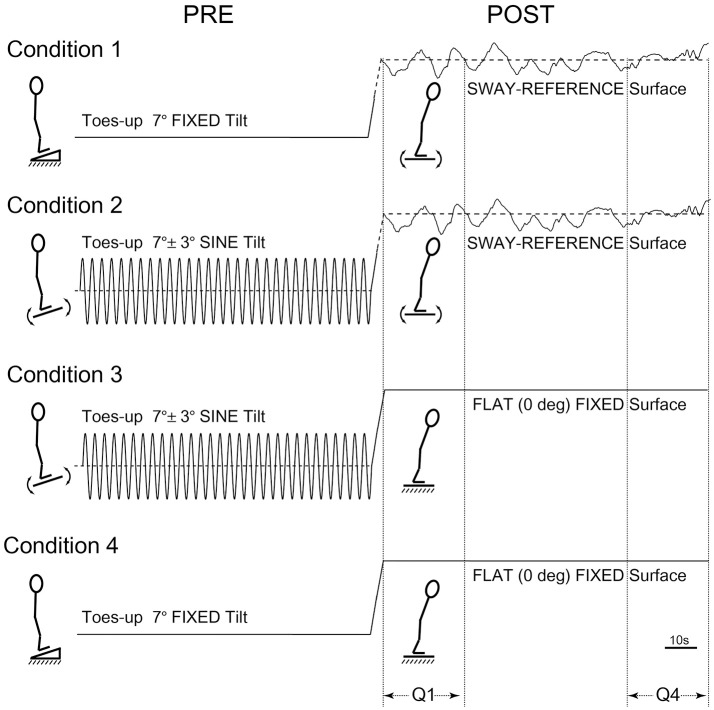
Postural test conditions. Condition 1: toes-up static-ramp for 120 s followed by standing on a sway-referenced surface for 120 s. Condition 2: toes-up sine-ramp (7° ± 3° * sinπt2 at 0.25 Hz) for 120 s followed by standing on a sway-referenced surface for 120 s. Condition 3: toes-up sine-ramp (7° ± 3° * sinπt2 at 0.25 Hz) for 120 s followed by quiet-stance on a static flat surface for 120 s. Condition 4: toes-up static-ramp (7°) for 120 s followed by quiet-stance on a static flat surface (120 s).